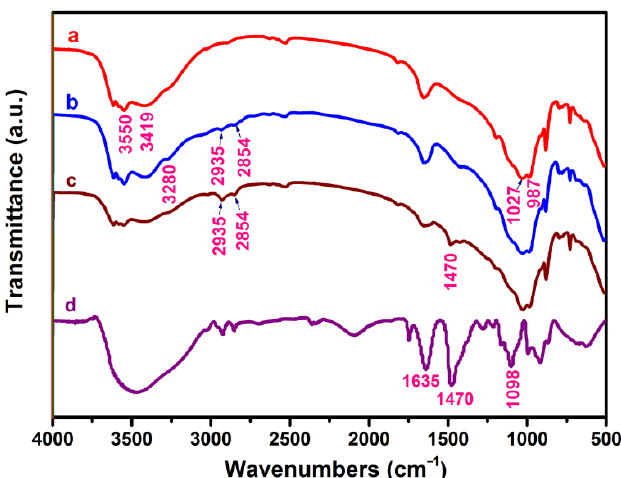
Figure 1. Fourier transform infrared spectroscopy (FTIR) spectra of samples. ( a ): attapulgite (ATP), ( b ): 3-aminopropyltriethoxysilane (APTES)-modified ATP (AM-ATP), ( c ): cation-modified ATP (CM-ATP), ( d ): polyepichlorohydrin-dimethylamine (EPI-DMA).